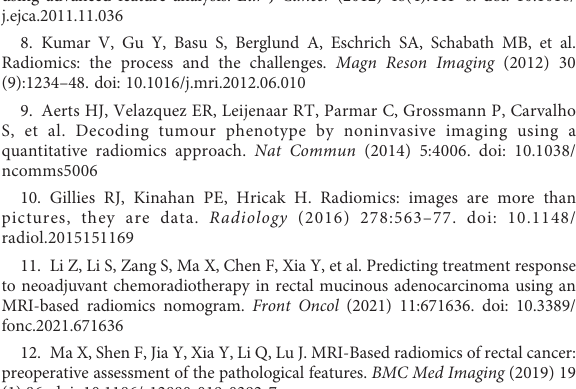
SUPPLEMENTARY TABLE 1 Main MRI sequences and parameters. SUPPLEMENTARY TABLE 2 Description of the selected radiomics features with associated feature groups and fi lters. SUPPLEMENTARY TABLE 3 Prediction performances of the nomogram model in all data sets. SUPPLEMENTARY FIGURE 1 Repeatability of radiomics features based on ICCs in different cohorts. SUPPLEMENTARY FIGURE 2 ROC curves for 10 models, PSA and PI-RADS, and comparisons (Delong test). SUPPLEMENTARY FIGURE 3 Correlation analysis of the selected ten optimal features of the whole prostate (T2WI) + lesion (DWI)